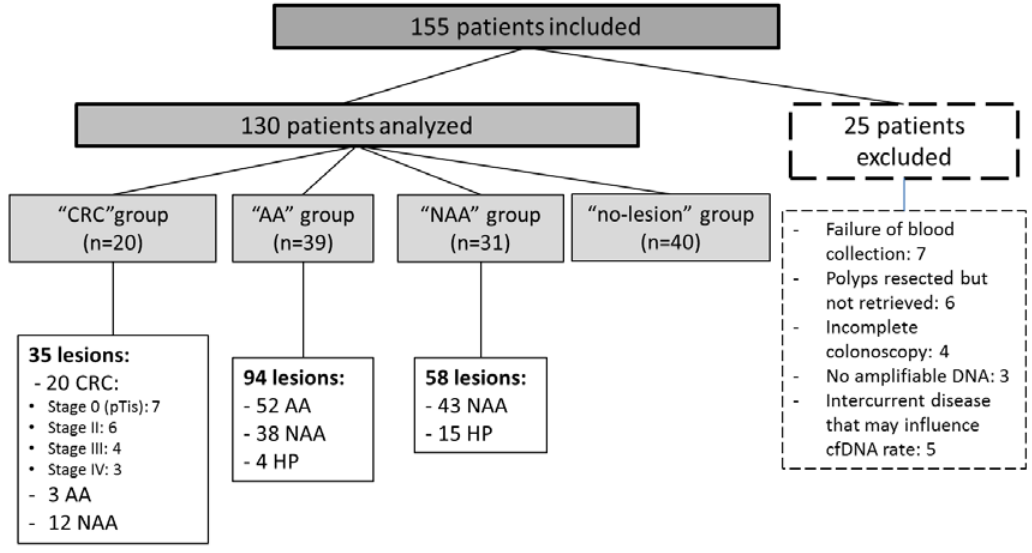
Figure 1. Flowchart. CRC group: colorectal cancer, AA group: patients with at least one advanced adenoma, NAA group: patients with non-advanced adenoma(s) and/or hyperplastic polyp(s), no-lesion group: patients with no colorectal lesion, cfDNA: circulating free DNA, AA: advanced adenoma, NAA: non-advanced adenoma, HP: hyperplastic polyps.